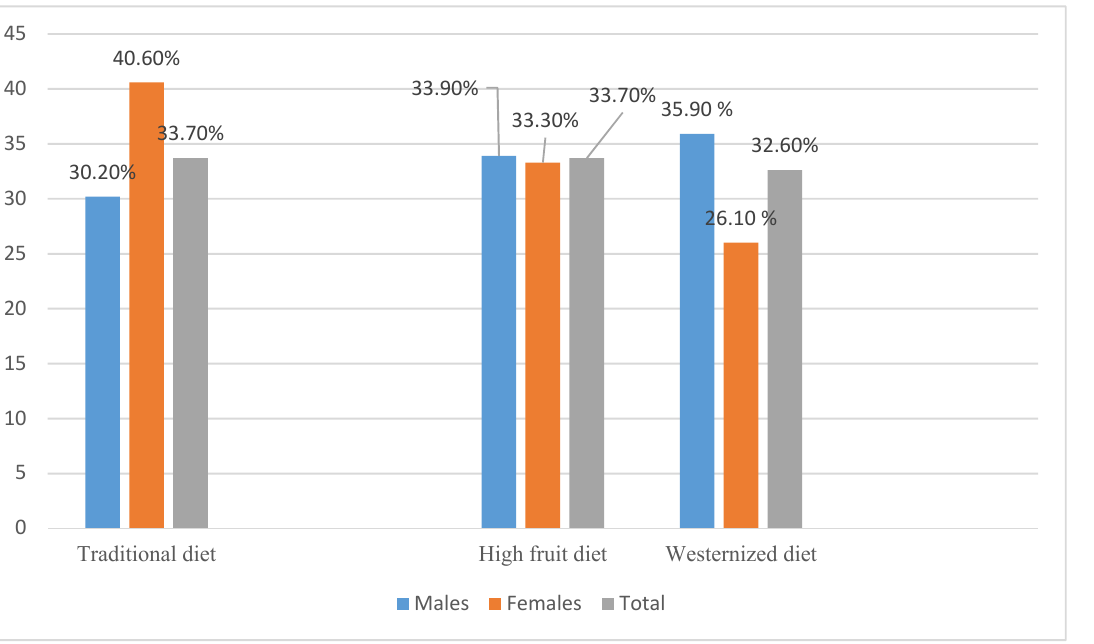
Figure 2. Dietary patterns distribution between males and females ( n = 320). Table 2. Factor loading matrix for the three identified dietary patterns in the study population.